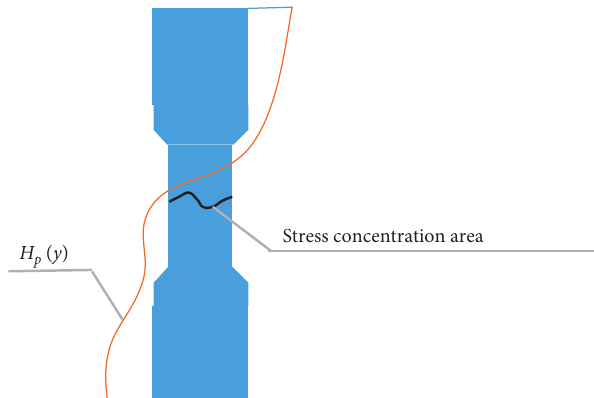
Figure 5: Relationship between stress concentration and normal component H p ( Y ) of magnetic memory signal.